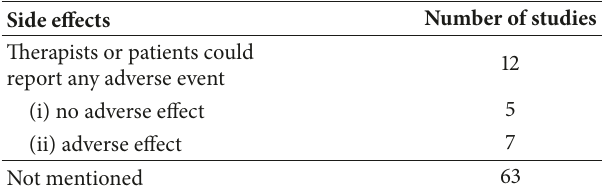
Table 17: Side effects in included studies.